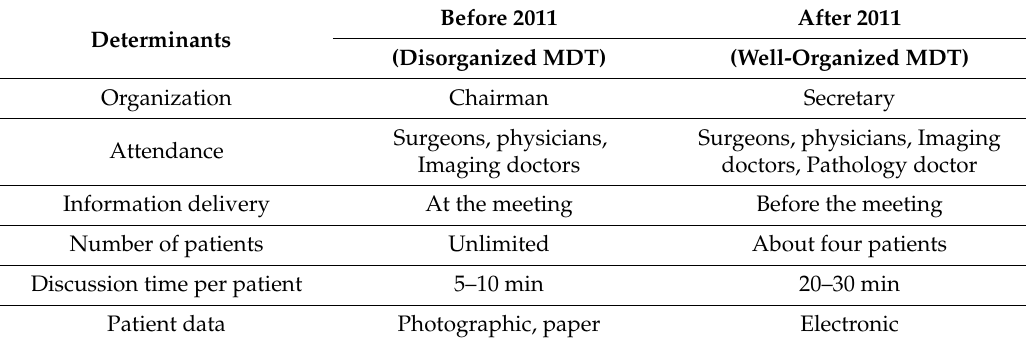
Table 1. The main organizational di ff erences of MDT before and after